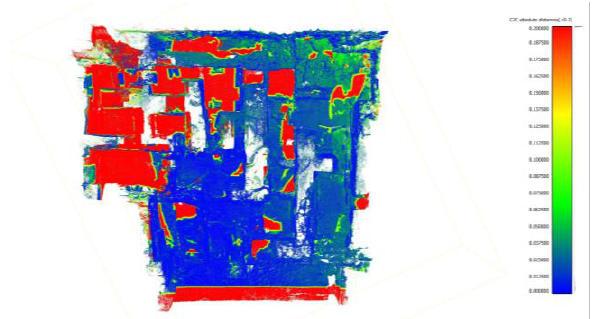
Figure 8. Comparison between the laser scanner point cloud and the Canon point cloud built in Metashape